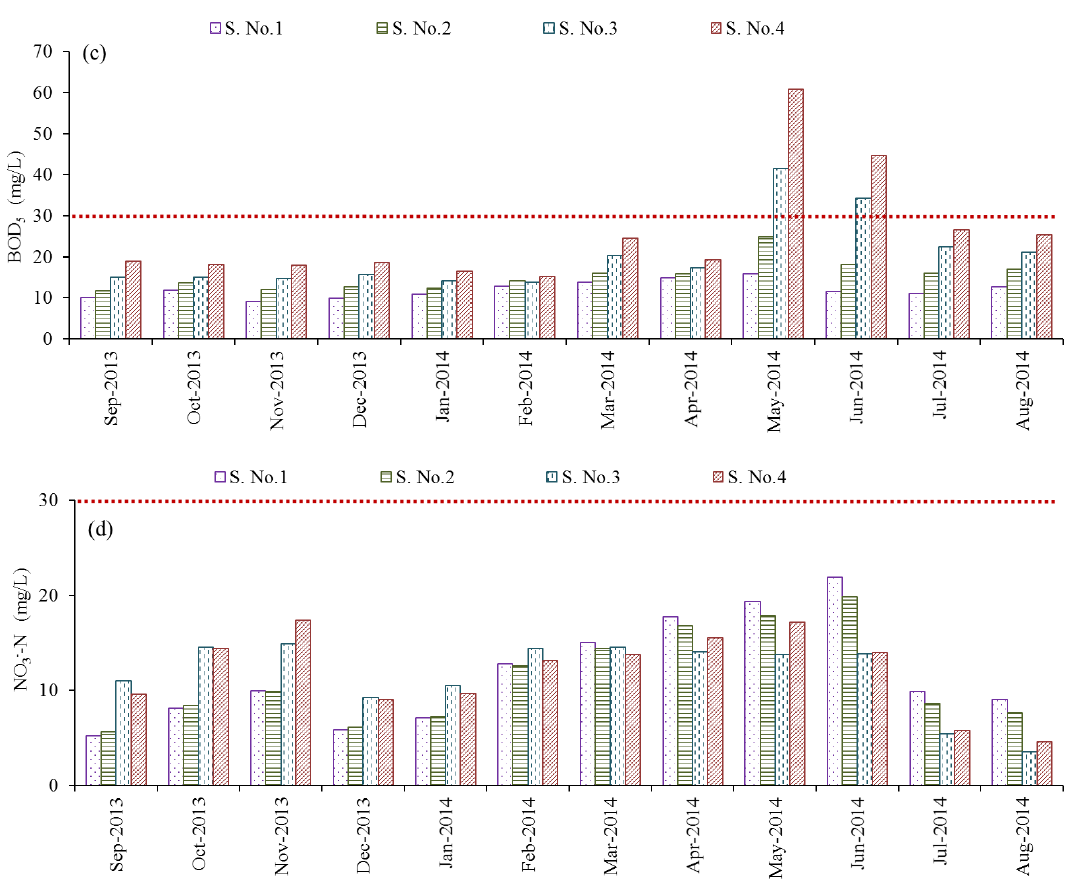
Figure 3. Simulated water quality parameters at four stations (S. No.1 to S. No.4) for the period from September 2013 to August 2014 in terms of: ( a ) TDS, ( b ) DO, ( c ) BOD 5 , ( d ) NO 3 -N. Table 6. Seasonal variances of the WQ parameters for the four stations.